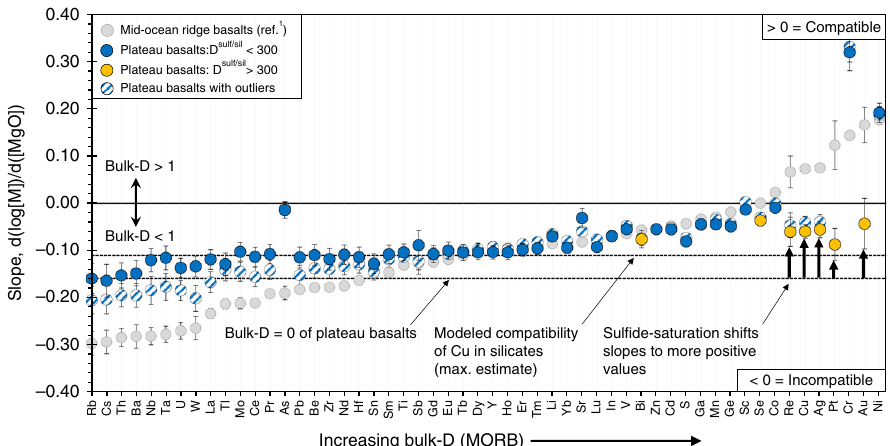
Fig. 5 Relative bulk-partitioning of trace elements during crustal differentiation of OPB and MORB. Relative bulk-partitioning values (slopes; see Methods for details) for each element are calculated following the method of O ’ Neill and Jenner 29 . Two slopes are modeled for OPB (including and excluding two outliers which are enriched in highly incompatible elements (e.g., Rb, Cs and Th) at a given [MgO] compared to the other OPB samples) to provide a best- estimate of the range in compatibility of each element during crustal differentiation. Elements are ordered by increasing compatibility (i.e., more positive bulk-partitioning values) during MORB differentiation (MORB slopes taken from Jenner 1 , except for Mo, Se, Sn, which were calculated using the new MORB data presented in Supplementary Table 4 and are listed in Supplementary Table 5; calculations performed without plume-in fl uenced MORB). Elements with a slope < 0 are incompatible (i.e., preferentially remain in the melt phase during fractional crystallization; bulk-D < 1) whereas elements with a slope> 0 are compatible (i.e., preferentially incorporated into silicates, sul fi de or oxides; bulk-D > 1). Together, CSE in OPB with a D sulf/sil > 300 (yellow symbols) are bulk-incompatible (bulk-D < 1), but have more positive slopes than Rb, which has an estimated bulk-D of ~0 and is therefore taken as a proxy for the behavior of CSE in a sul fi de-under-saturated melt. These offsets (black arrows) suggest that the melts reached sul fi de-saturation during differentiation. Importantly, Cu is offset to a higher slope compared to a modeled bulk-D which assumes the behavior of Cu in the melt during differentiation is controlled solely by partitioning into silicate phases. Error bars are the standard error of the slope (see